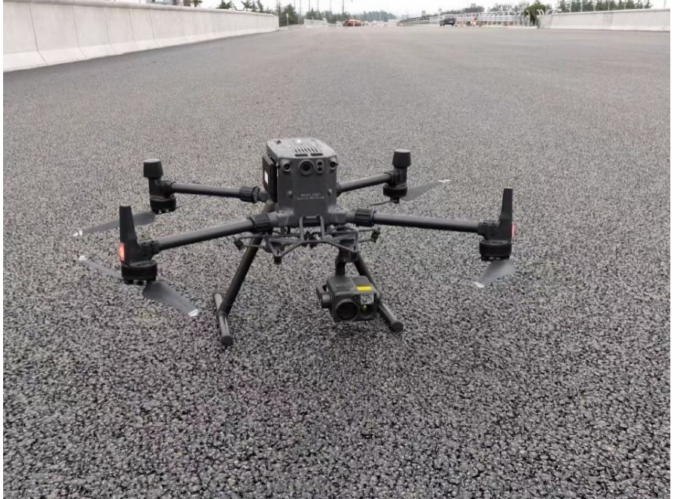
Figure 1. M300 RTK UAV.